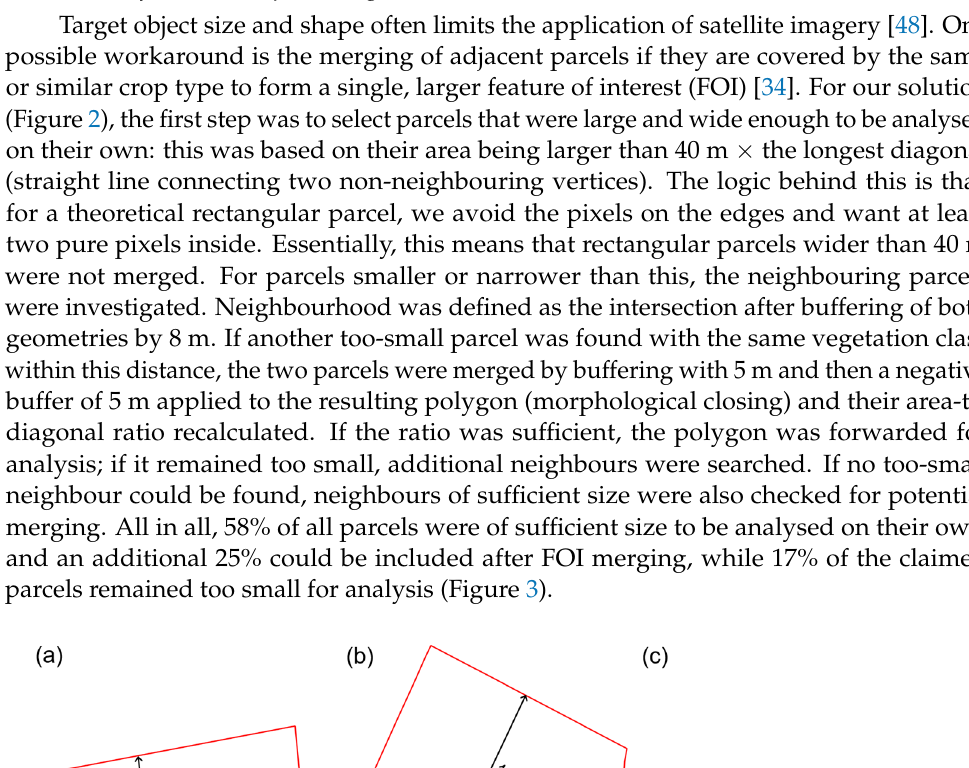
6: Red Edge 2, Band 11: Shortwave Infrared 1, and Band 12: Shortwave Infrared 2); and five derived spectral indices (Table S3): NDVI [49], BSI (Bare Soil Index) [50], EVI (En- hanced Vegetation Index) [51], SIPI (Structure Insensitive Pigment Index) [52], and YCI (Yellow Crop Index). YCI was purposefully designed for this study for selective identifi- cation of crops characterized by a yellow flowering phase (e.g., oilseed rape): YCI = (B04 + B03) – (2 × B02) (1) YCI returns a high value when both the red and the green channel are high and the blue is low—so when the surface is bright yellow. In all other cases, the index has lower values. 2.6. Random Forest Classification Random forest (RF) was chosen as a classification method due to its robustness to errors in the training data and reasonable computation time [53]. The RF classifier has been shown in earlier studies to yield excellent classification results and to successfully handle the high data dimensionality and multicollinearity of remotely sensed data [54]. Additionally, the option for a fuzzy classification output was considered and extensively used during analysis. Fuzzy classifiers generate, for each classified unit, a vector of the respective probabilities of every class [23]. On one hand, for specific vegetation classes, this output allowed including them in the evaluation even if they were not the dominant category (such as weeds or reeds); on the other hand, the fuzzy output also allowed cal- culation of a classification certainty metric for each FOI. Several such metrics are in use; we applied the probability surplus index [55], also known in active learning as the “break- ing ties index” [56], as a direct representation of probability of the final class above the second-most-probable class—and thus the true certainty of the decision. Variable im- portance was calculated based on the impurity decrease, also known as a Gini importance [53]. RF classification was implemented in the Scikit-learn Python module (Figure 2) [20]. Two parameters need to be set for RF: we set the number of decision trees to be generated (n_estimator) to 200 and the number of variables to be selected for the best split